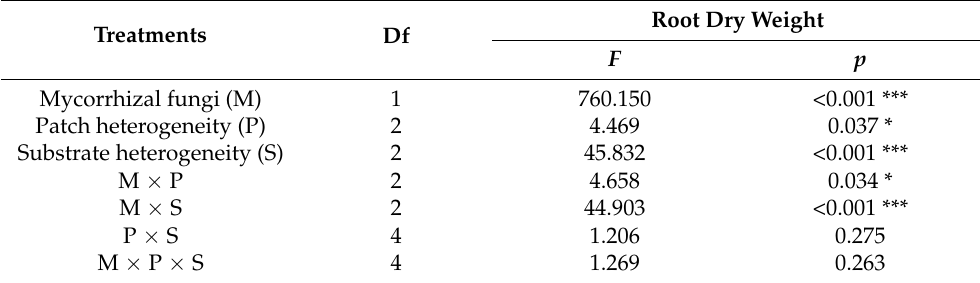
Table 2. Three-way ANOVA for the effect of mycorrhizal fungus (M + vs. M − ), patch heterogeneity (Homo vs. Hetl vs. Hets), and soil substrate heterogeneity (GL vs. GF vs. GH) on the dry weight of roots.